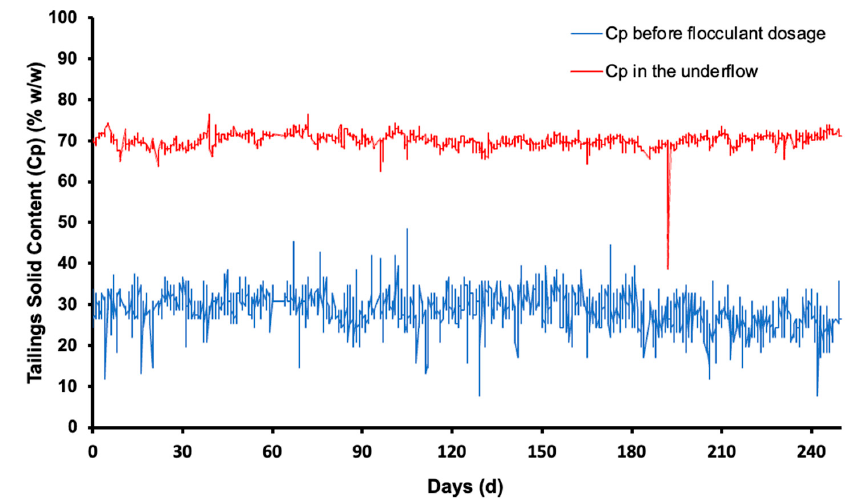
Figure 2. Tailing solids content of the Florida mine tailings at the inlet and outlet of the thickener (with the addition of flocculant dosage). The flocculant used for thickening was ORIFLOC AP 2020, a polyacrylamide powder, with a low anionic charge and high molecular weight. The added dosage was 28.3 ± 6.9